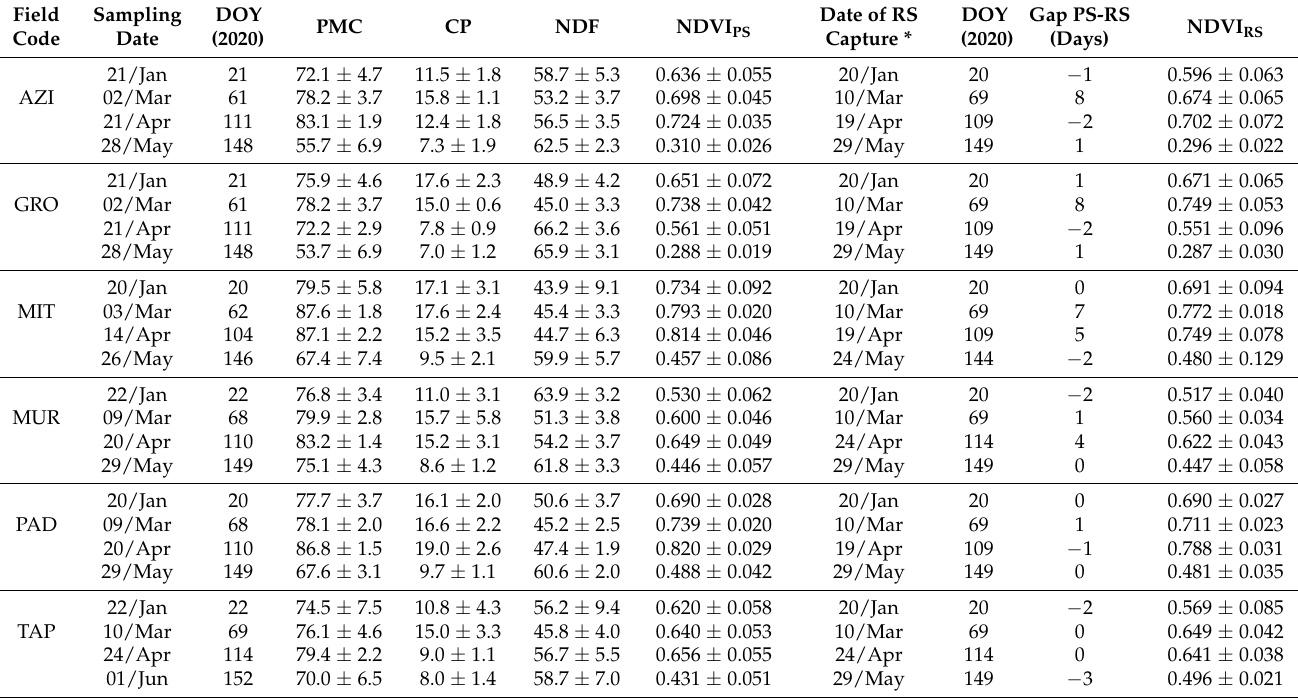
Table 3. Mean ± standard deviation of pasture parameters (PMC, CP, and NDF) and NDVI obtained by proximal and remote sensing in